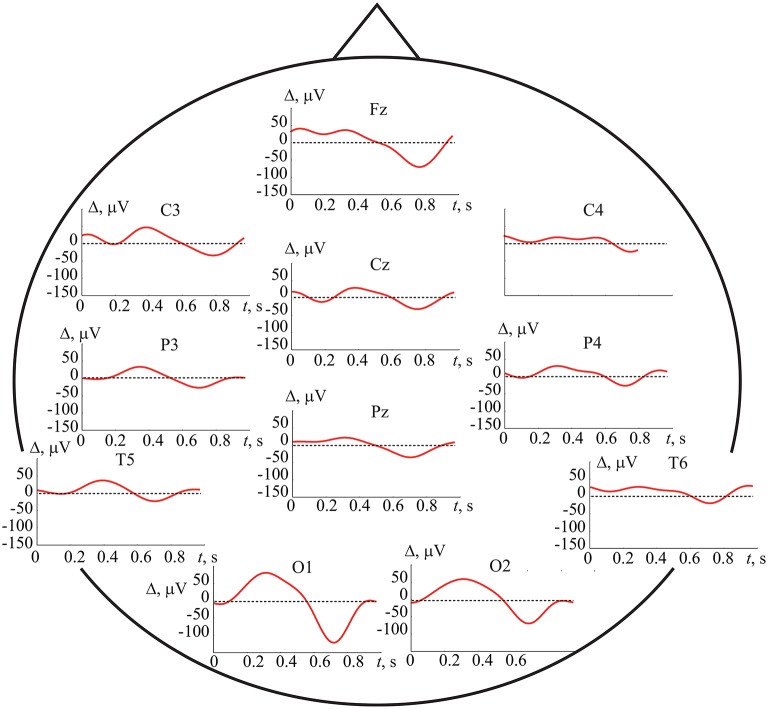
Averaged EEG difference traces Δ(t) for subject h = 4 recorded from 11 electrodes.